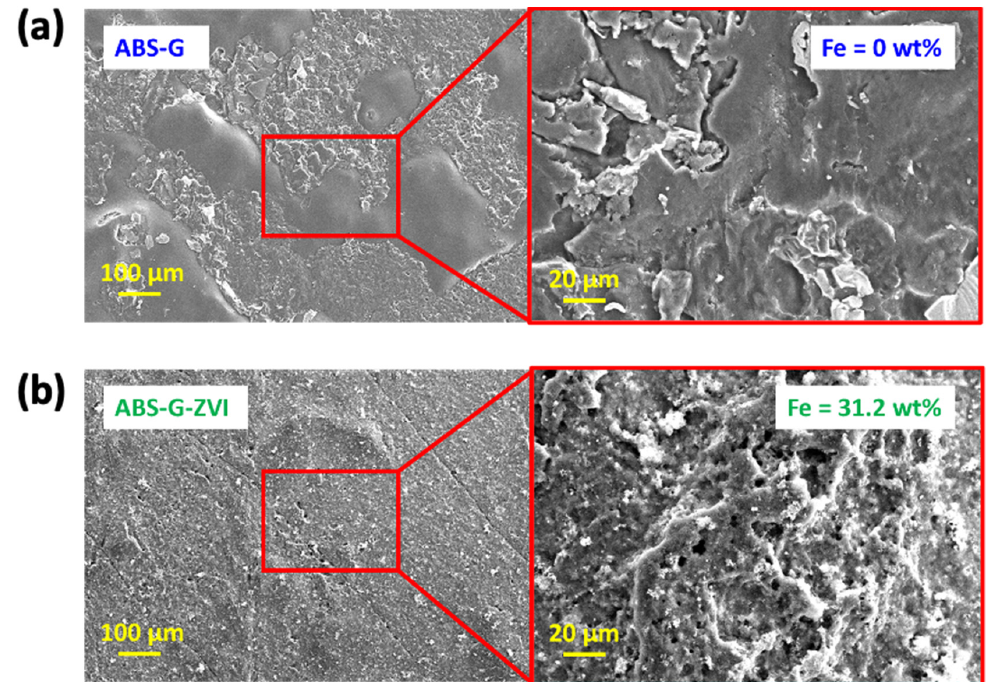
Figure 2. ( a ) Field-emission scanning electron microscope (FE-SEM) and EDX images of the 3D printed ABS-G electrode; ( b ) FE-SEM and EDX images of the 3D printed ABS-G electrode with electrochemically deposited ZVI.